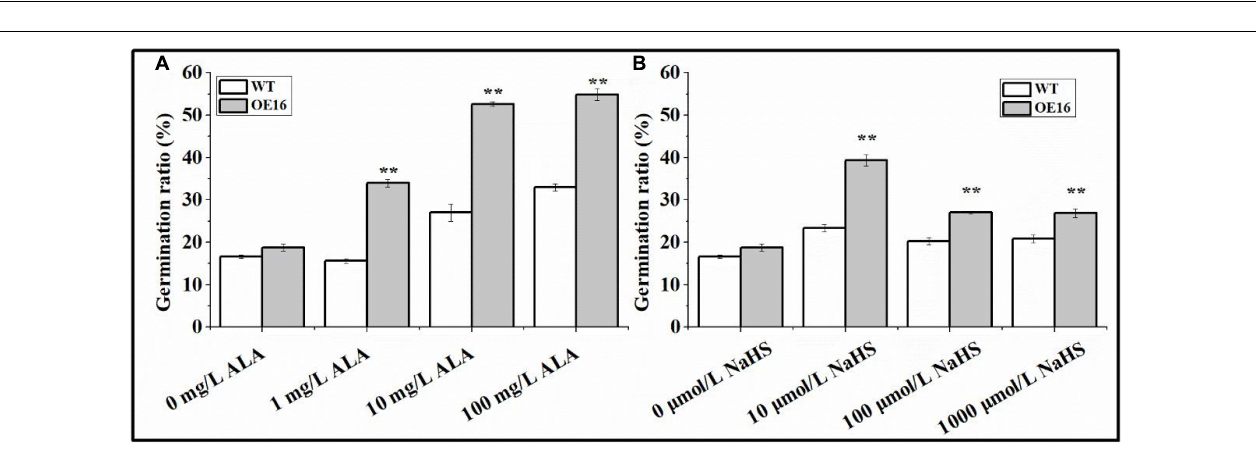
FIGURE 9 | The response of seeds from CaALAD -overexpressing plants to exogenous ALA and NaHS. (A) The germination rates of transgenic seeds treated with 1 mg/L ALA, 10 mg/L ALA, and 100 mg/L ALA. (B) The germination rates of transgenic seeds treated with 10 µ mol/L NaHS, 100 µ mol/L NaHS, and 1,000 µ mol/L NaHS. WT: Arabidopsis Col-0. OE: the CaALAD -overexpressing (OE) lines. NaHS: the donor of hydrogen sulfide. The error bars are the standard errors for three independent tests and asterisks indicate significant differences from the WT at ** p < 0.01.